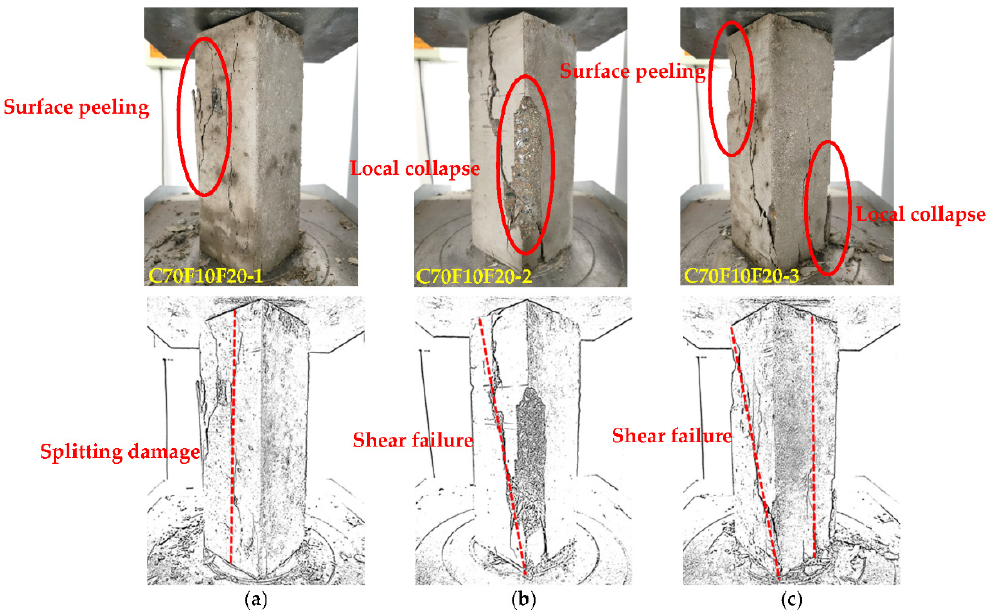
Figure 11. C70F10G20 group concrete axial compression failure. ( a ) Splitting damage, surface peeling; ( b ) Shear failure, local collapse; ( c ) Split failure, shear failure.